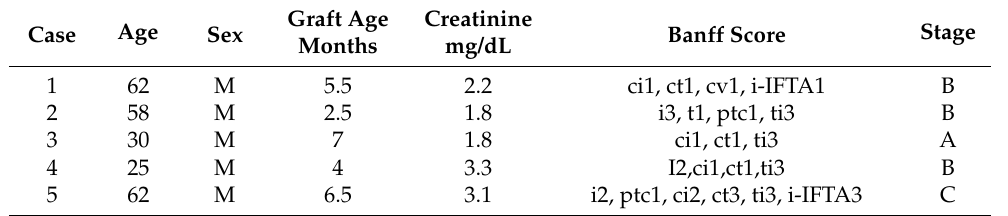
Table 2. Basic data of BK virus nephropathy